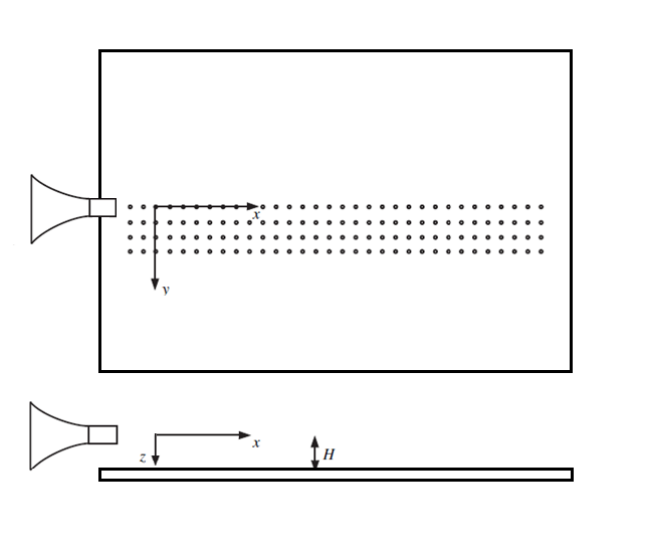
Figure 1. Experimental